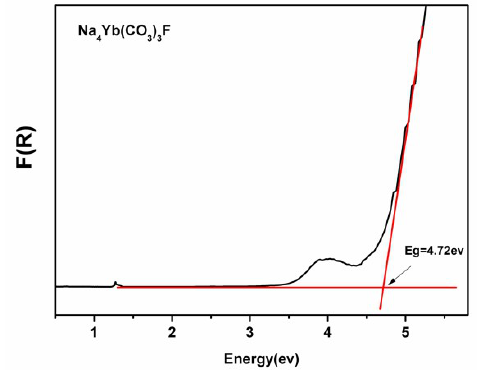
Figure 4. Optical diffuse reflectance spectra for Na 4 Yb(CO 3 ) 3 F.